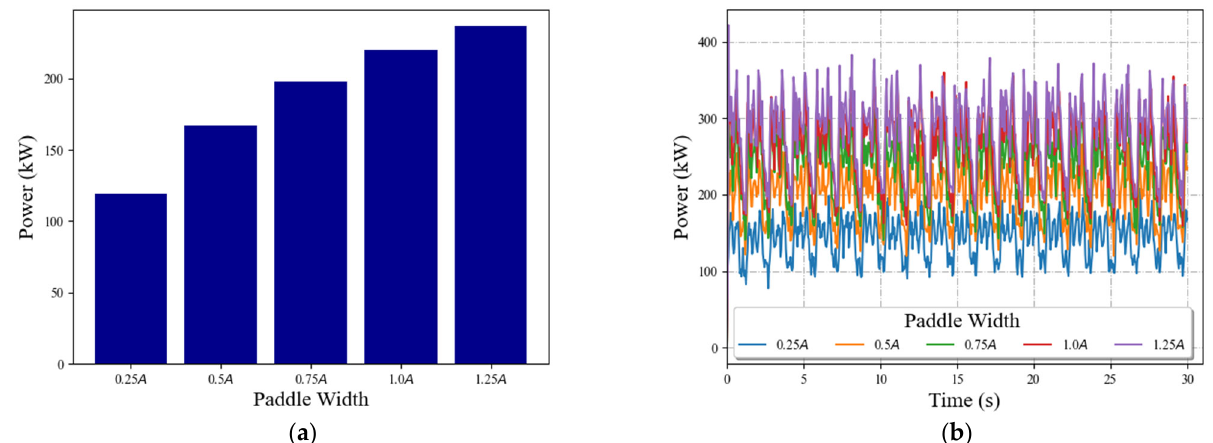
Figure 21. Power consumption of the mixer in various paddle widths: ( a ) mean power consumption and ( b ) transient power consumption.